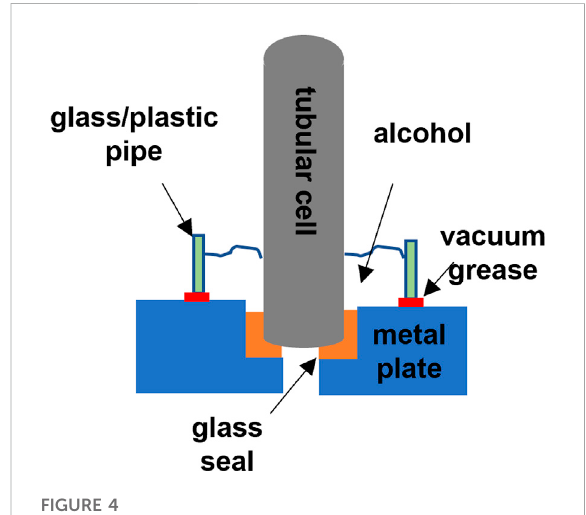
FIGURE 4 Schematic drawing of the leak test for tubular cells.